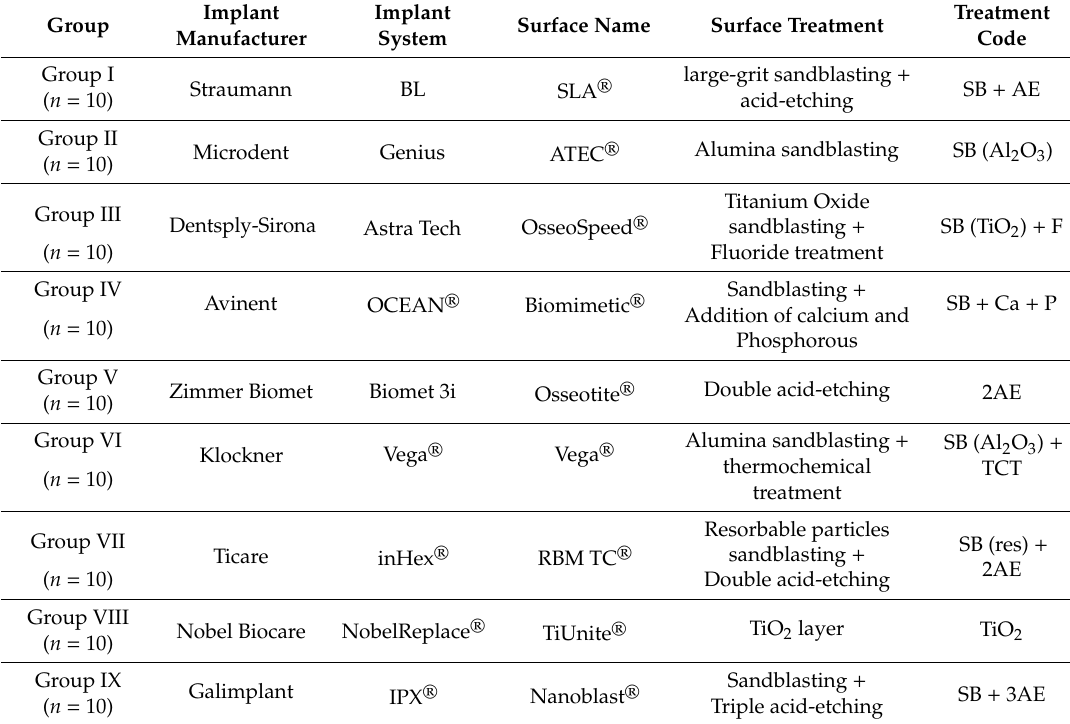
Table 1. Implant manufacturer, implant system, surface name, surface treatment, and surface treatment code of each of the nine experimental